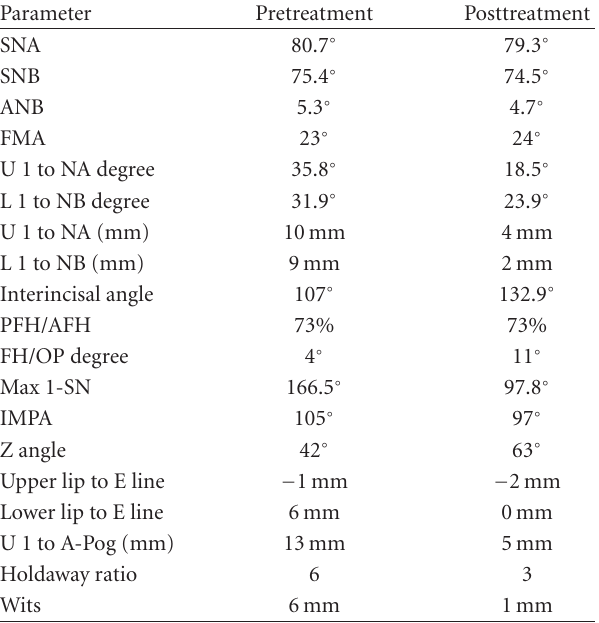
Table 1: Cephalometric analysis